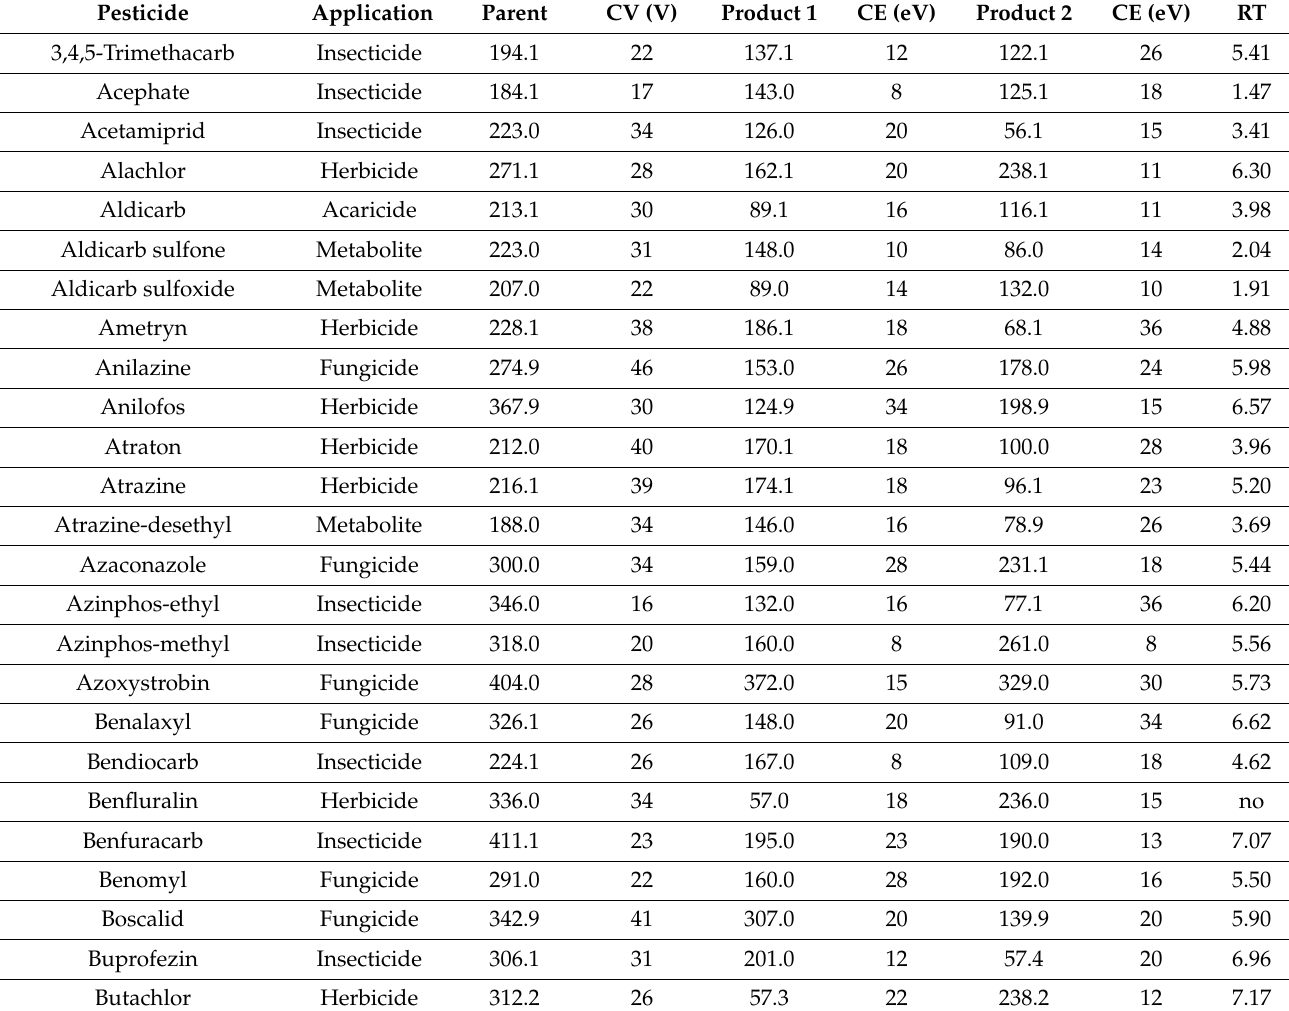
Table 4. LC-MS/MS retention times and multi reaction monitoring MRM transitions for the LC amenable